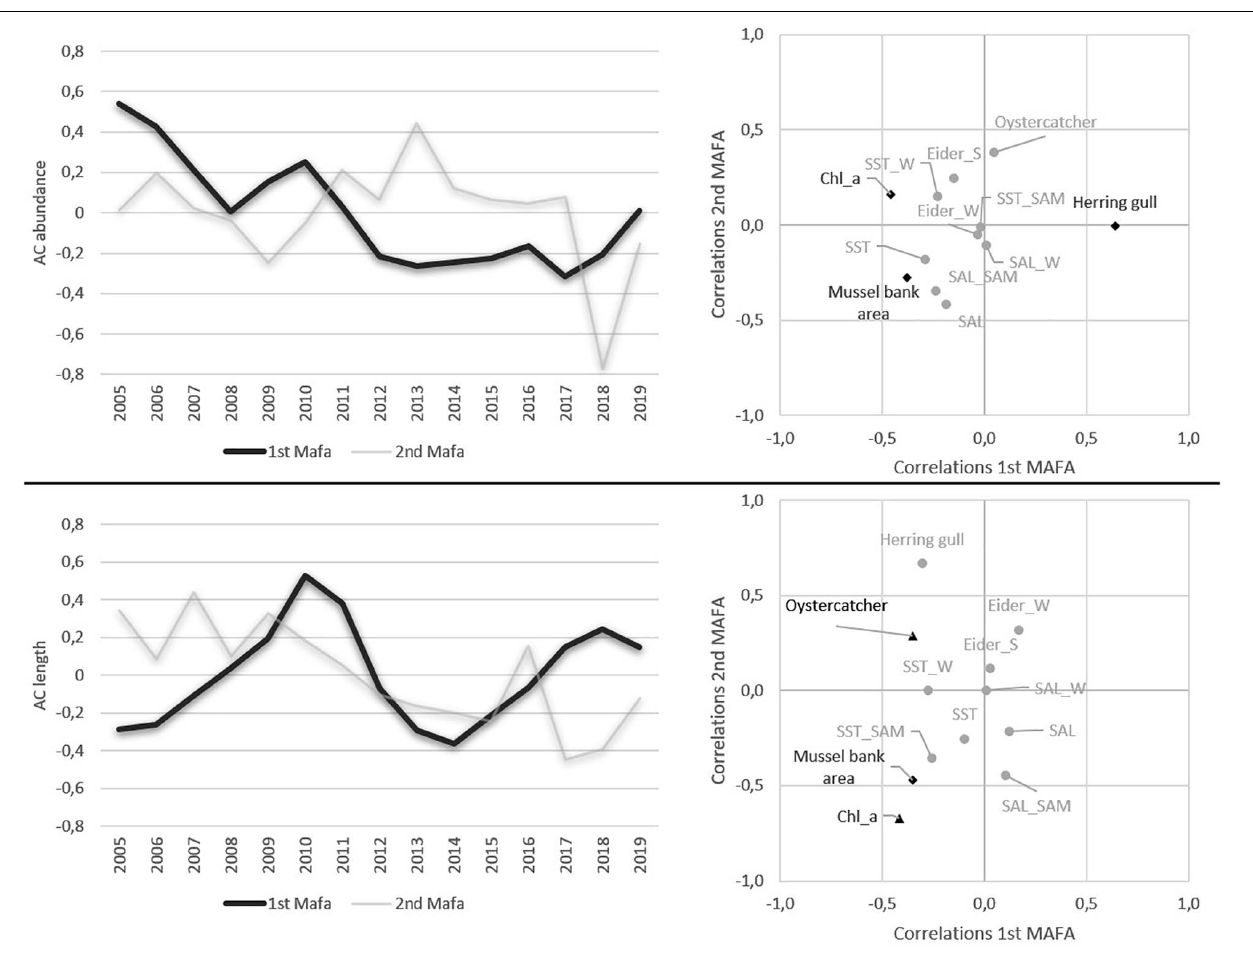
FIGURE 9 | Results of min/max autocorrelation factor analysis (MAFA) and canonical correlations. SST, mean annual sea surface temperature anomaly; SST_SAMP, mean annual sea surface temperature anomaly during sampling; SST_W, mean annual sea surface temperature anomaly in winter; SAL, mean annual salinity anomaly; SAL_SAMP, mean annual salinity anomaly during sampling; SAL_W, mean annual salinity anomaly in winter; Chl_a, chlorophyll a; Eider_W, abundances of common eider in winter; Eider_S, abundances of common eider in summer; Mussel bank, mussel bank area; Herring Gull, abundances of herring gulls at Mellum; Oystercatcher, oystercatcher abundances; Abundance, mean cockle abundance; Length, mean cockle